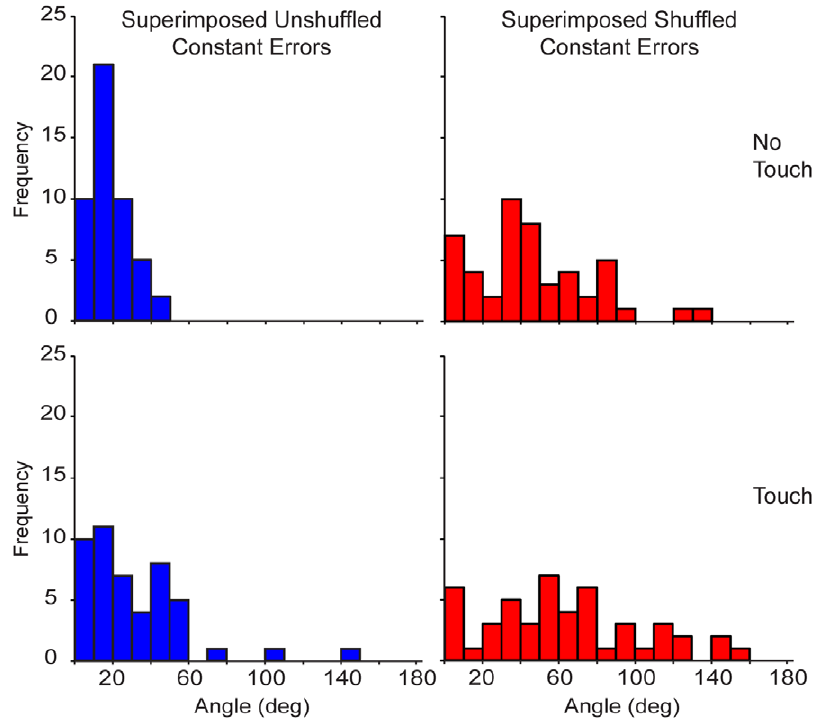
Figure 4. Histograms of the angles between the superimposed vectors. The left histograms show the angle distribution of the superimposed constant error vectors across hands for the subject displayed in Figure 3. The right histograms show the angle distribution of the superimposed vectors when the constant errors from one hand were shuffled before being superimposed.